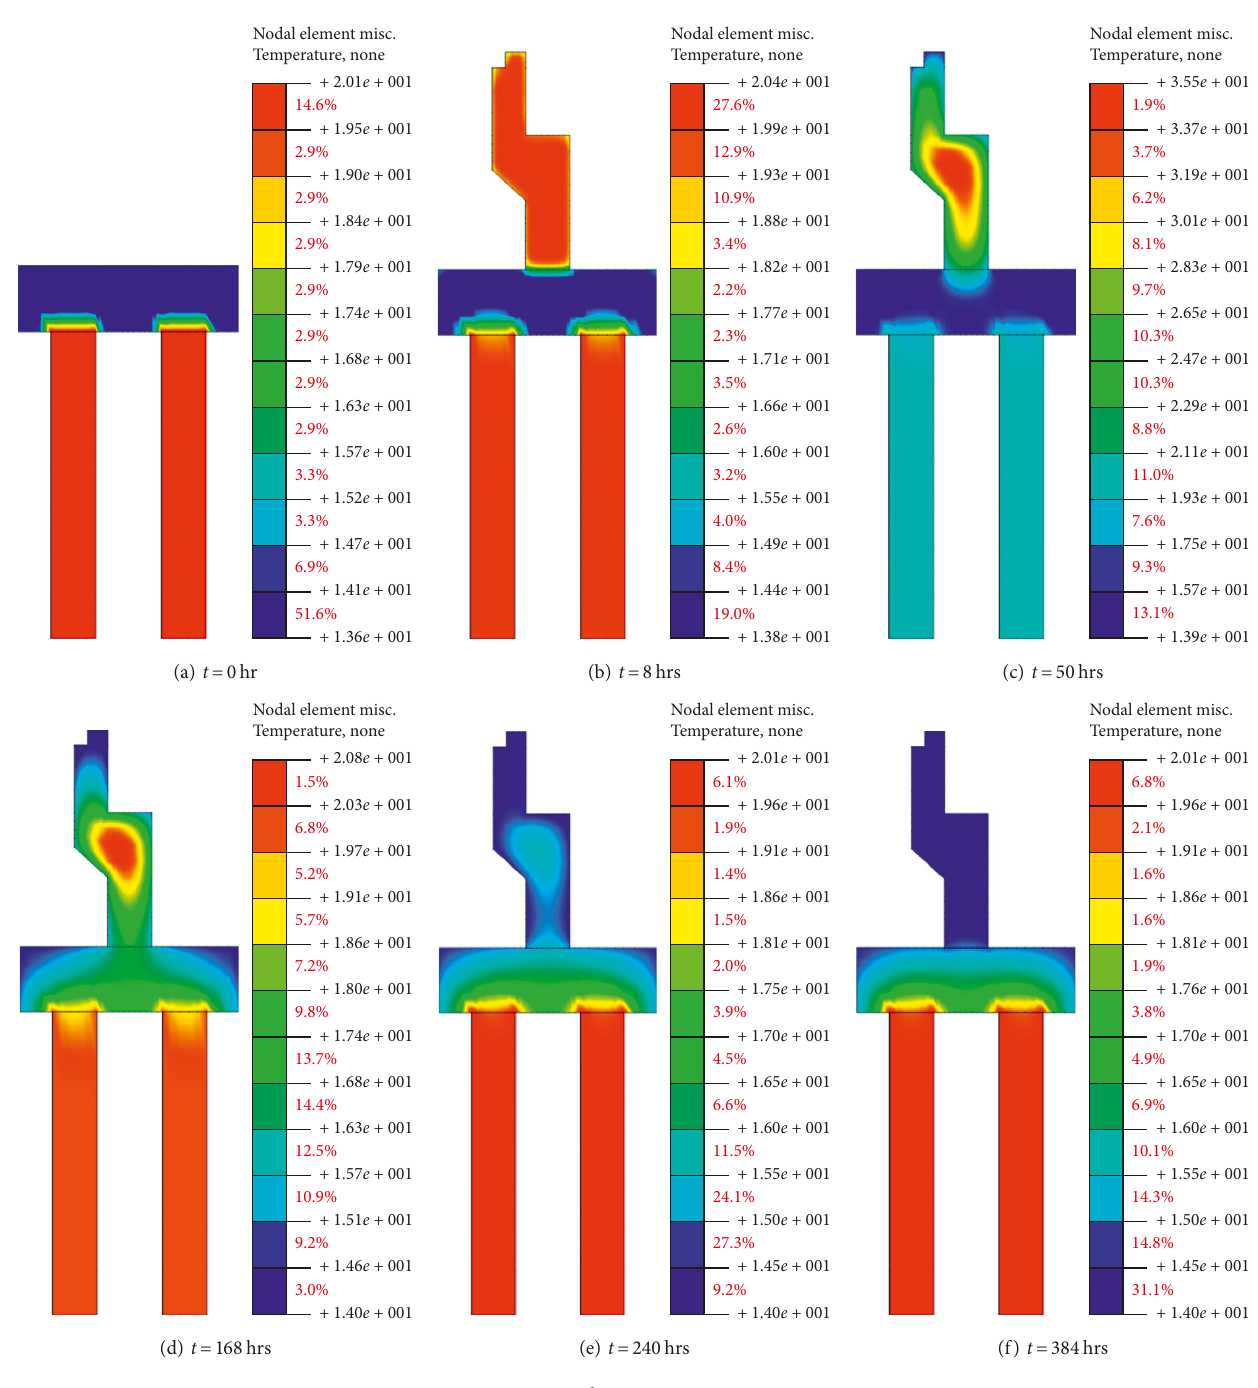
Figure 8: Abutment